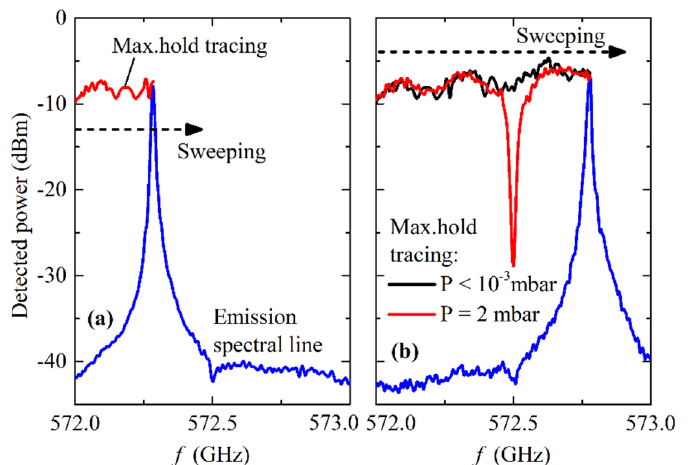
Figure 7. Recording of the gas absorption lines by the “maximum hold” regime of the spectrum analyzer, using a frequency sweeping of the FFO emission line: ( a ) The emission line still did not pass the frequency of absorption; ( b ) The emission line passed the frequency of absorption.